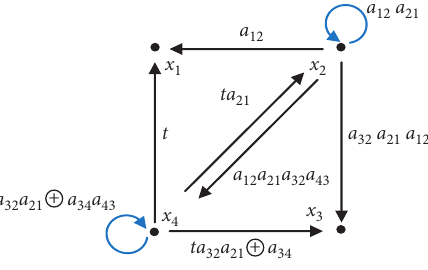
Figure 5: Precedence graph G (D) of matrix D